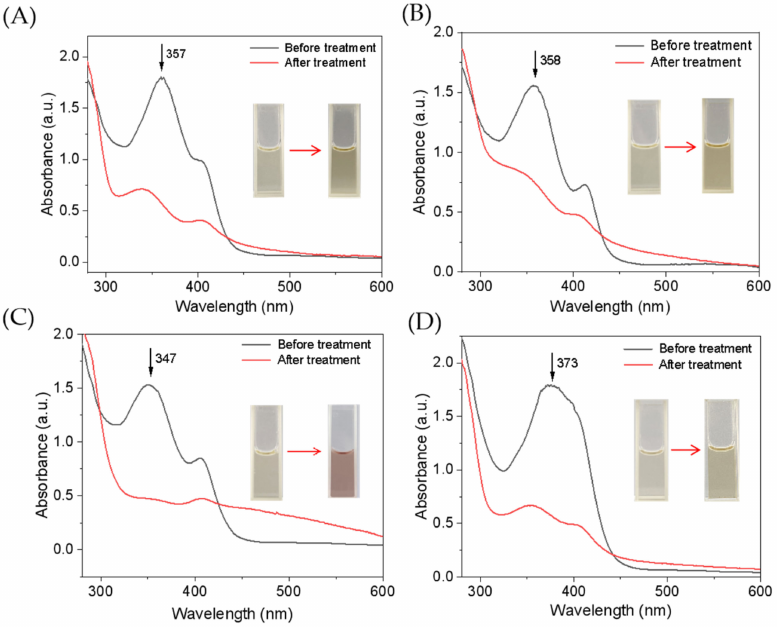
Figure 2. UV–vis absorption spectra of tetracycline antibiotics (100 µ M) before and after treatment by F43Y/P88W/F138W Mb (5 µ M) in the presence of H 2 O 2 (400 µ M) for 5 min: ( A ) TC, ( B ) OTC, ( C ) DXC, and ( D ) CTC. Inset shows the color change of the substrate solution before and after